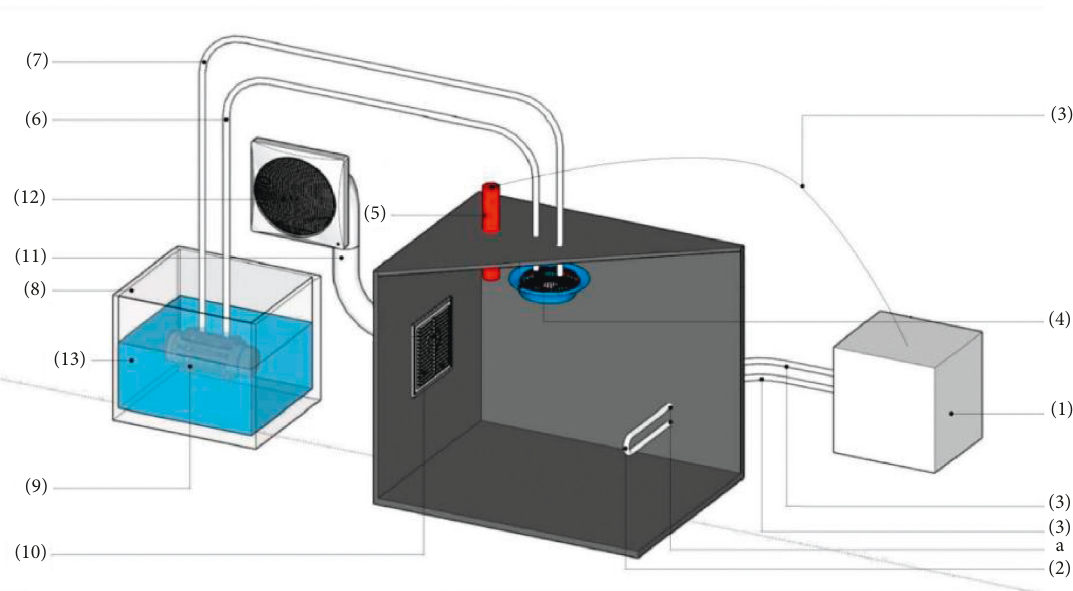
Figure 3: A concrete durability test chamber under salt spray erosion.